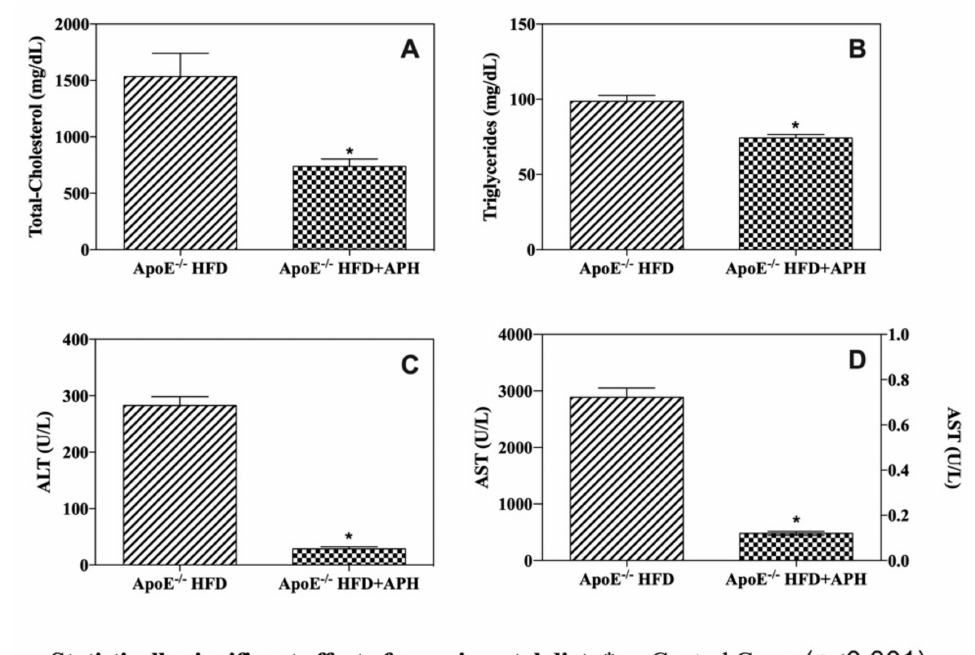
Figure 3. Serum lipid levels and hepatic enzyme activity. Administration of APH for 12 weeks produced significant serum total cholesterol and triglycerides-lowering e ff ects ( A , B ). Serum ALT (alanine aminotransferase) ( C ) and AST (aspartate amino transferase) ( D ) levels were statistically lower in ApoE – / – HFD + APH compared to the control group ( p < 0.0001), suggesting minor damage of the hepatocytes. Data are presented as mean ± SD for n = 6 mice per group. Abbreviations: HFD high-fat diet, APH anchovy protein